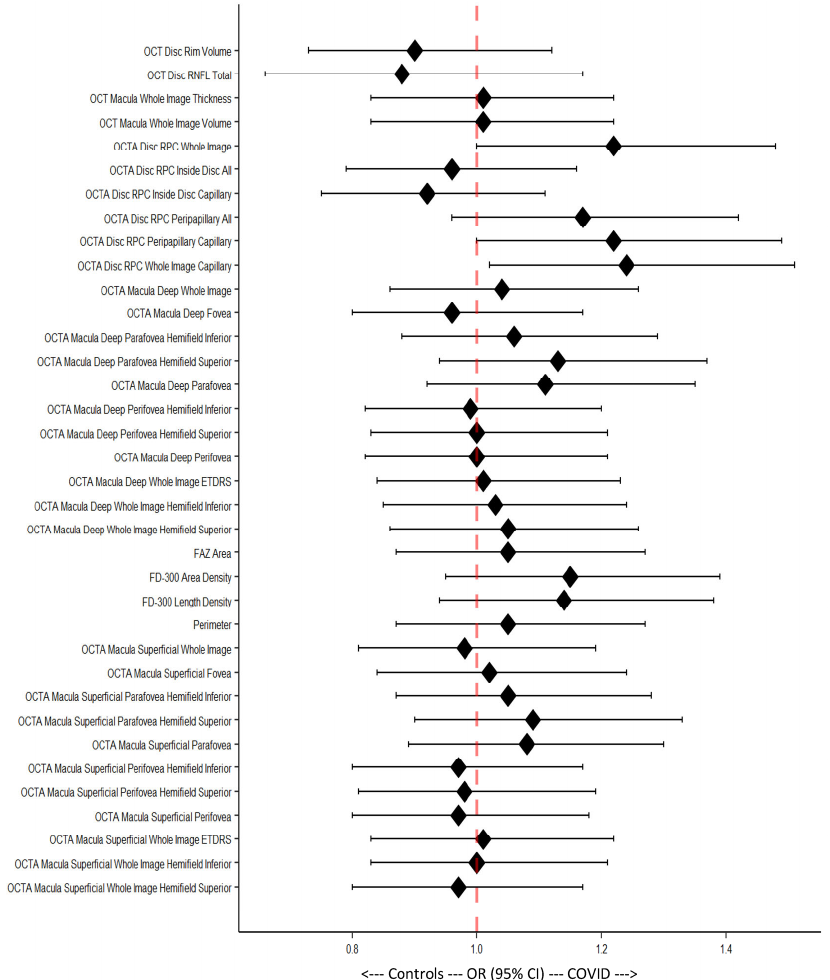
Figure 6. Forest plot of Odds ratios (ORs) with 95% confidence intervals (95% CIs). Each 95% CI that includes the middle line (do tt ed, red) is considered statistically non-signi fi cant.